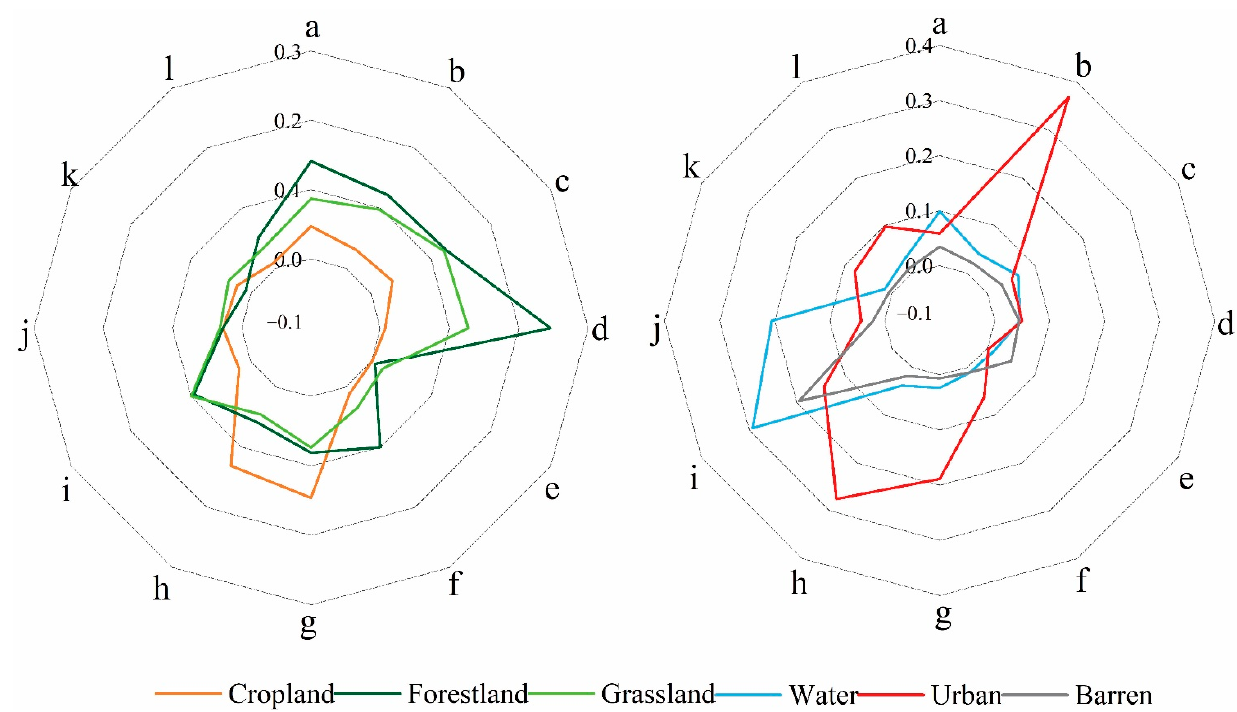
Figure 10. Importance of driving factors. (a. Elevation b. Slope c. Temperature d. Precipitation e. Soil erosion f. Soil type g. GDP h. Population i. NDVI j. Distance to water k. Distance to roads l. Distance to railroad) .